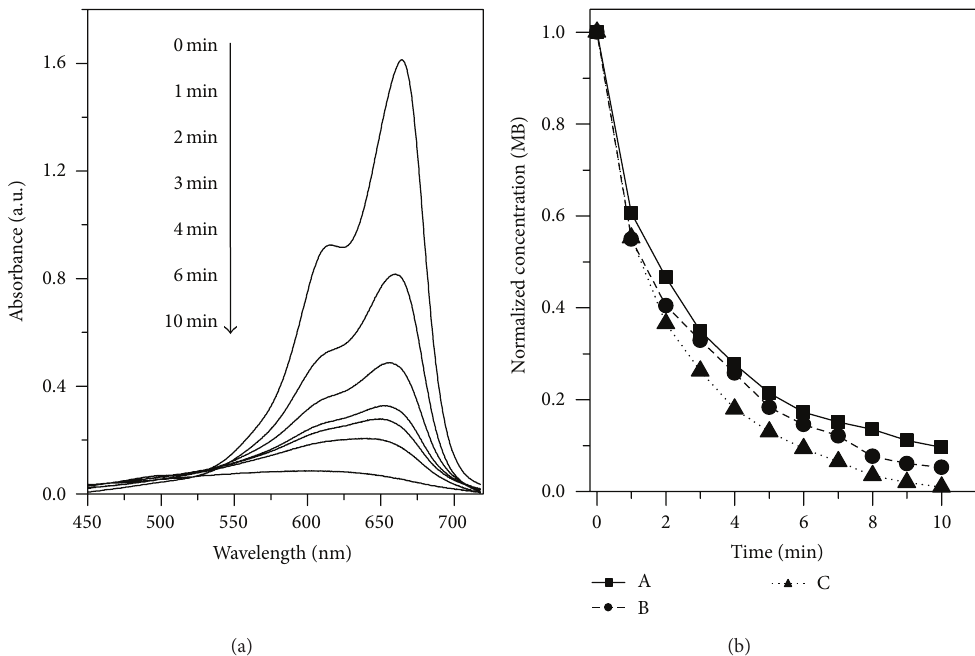
Figure 8: (a) The time dependent absorption spectra for CuS thin film vacuum annealed at 150 ∘ C and HP. (b) Change in the concentration of MB under different experimental conditions. Absorption spectra of A only have hydrogen peroxide, B thin film of the CuS without annealing and HP, C thin film, and CuS with annealing at 150 ∘ C and